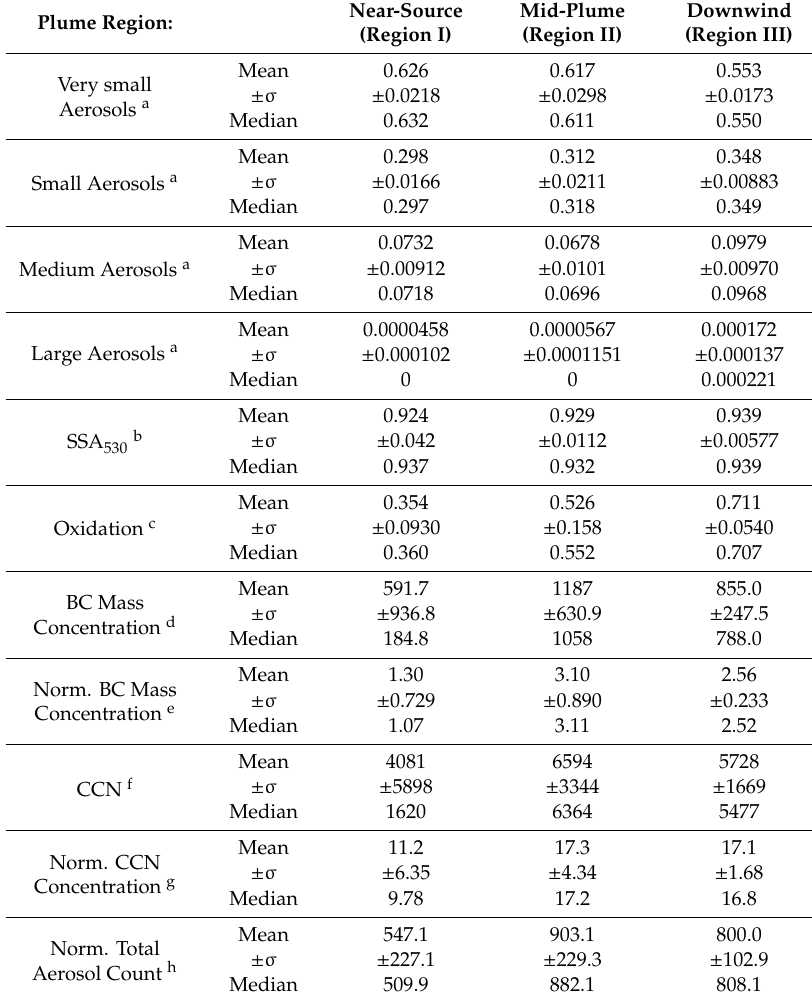
Table 3. Aircraft data aggregated by plume region: aerosol size, chemical, and physical properties for the Williams Flats Fire measured in situ on 06 August 2019. Norm.–